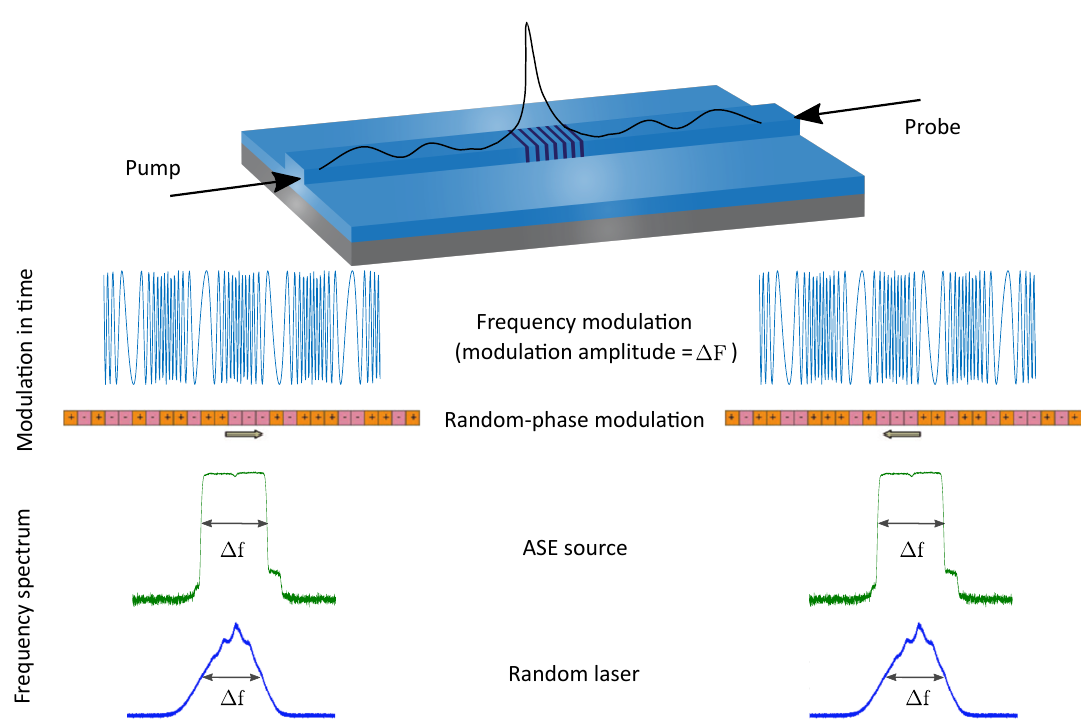
Figure 3. Schematic of various sources for BOCDA measurement from the top to the bottom: frequency-modulated laser source with a modulation amplitude of ∆ F [43], random phase coded laser source [44] (Copyright ©2012 WILEY-VCH Verlag GmbH & Co. KGaA, Weinheim), amplified spontaneous emission (ASE) source with spectral width of ∆ f [47,48] (adapted from [48] under a Creative Commons Attribution 4.0 International Public License), and a random laser based on a distributed feedback laser diode in an external feedback cavity [91] with a spectral width of ∆ f (adapted with permission from [91],